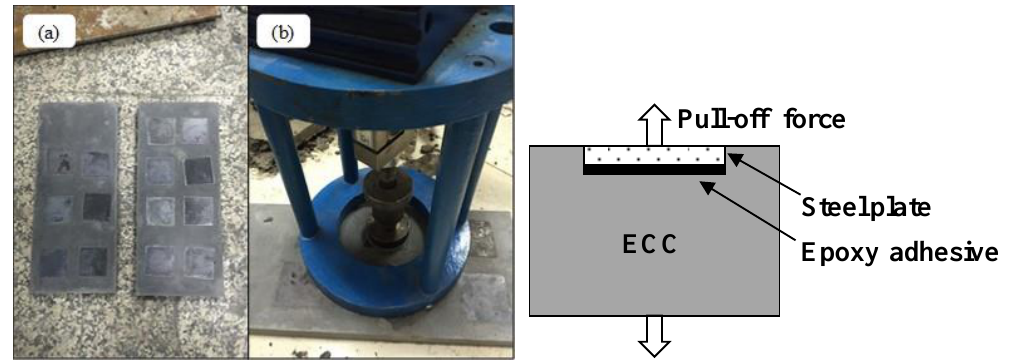
Figure 5. Pull-off test: (a) Specimen, (b) Instrument.